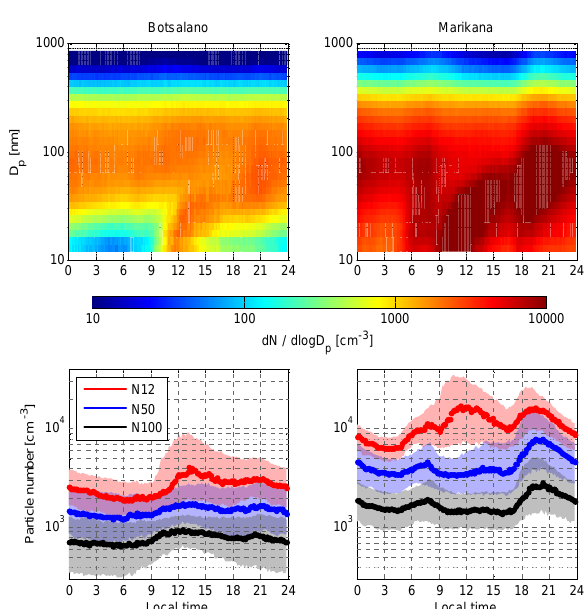
Fig. 4. Median diurnal variation of the aerosol particle size distribu- tion for Botsalano and Marikana. In the lower panels the upper and lower quartiles are indicated by the shaded